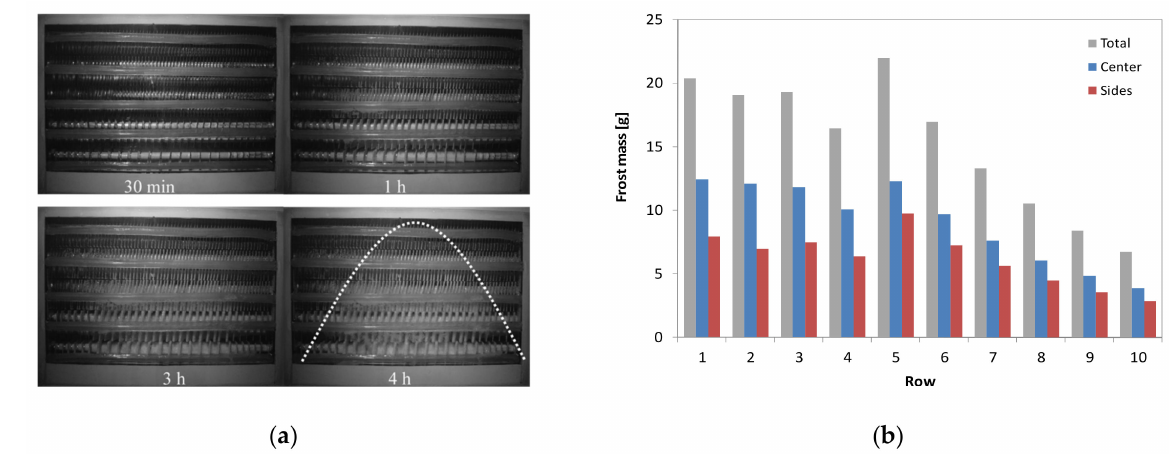
Figure 12. Two-dimensional frost accumulation over an evaporator coil: visualization ( a ), and simulation results ( b )